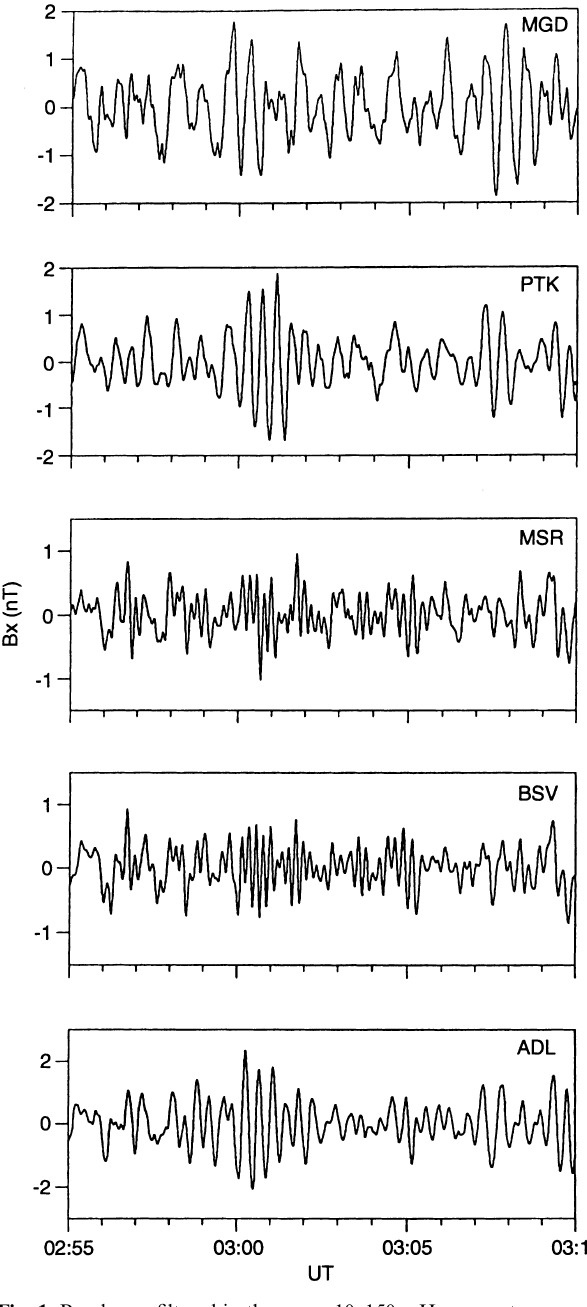
Fig. 1. Band-pass filtered in the range 10–150 mHz magnetograms of H -component of pulsations, recorded on October 15, 1992, 02:55– 03:10 UT at mid-latitude stations of the 210 (cid:14) meridional network